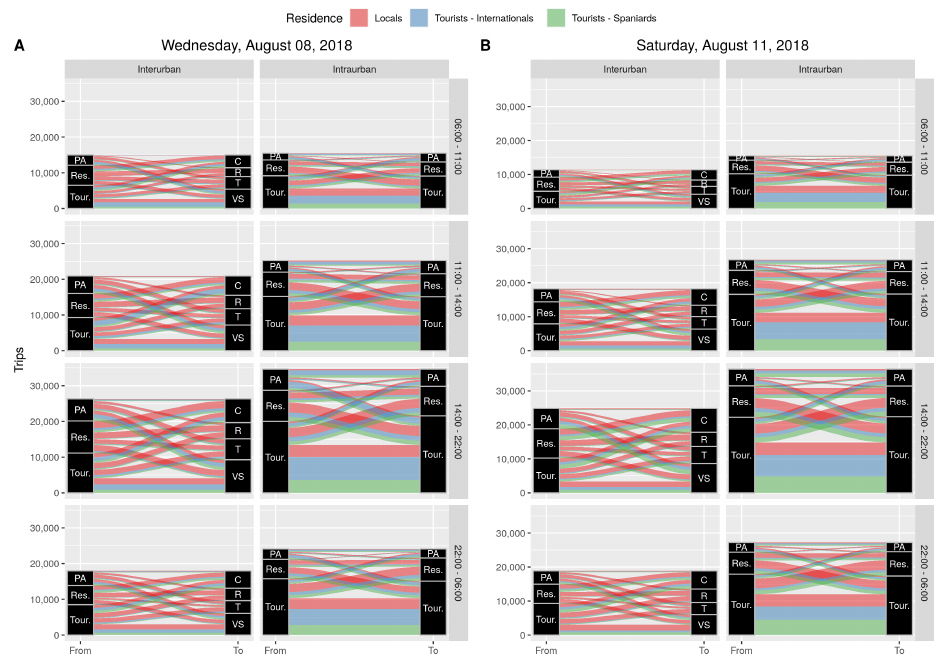
Figure 8. Alluvial diagrams showing the summer mobility of local residents, national tourists, and international tourists in Salou. Intra-urban mobility shows the movements between the different areas of Salou—PortAventura (PA), Residential (Res), Tourist (Tour), while inter-urban mobility shows the movements from these areas to the most important municipalities in the area—Cambrils (C), Reus (R), Tarragona (T), and Vila-seca